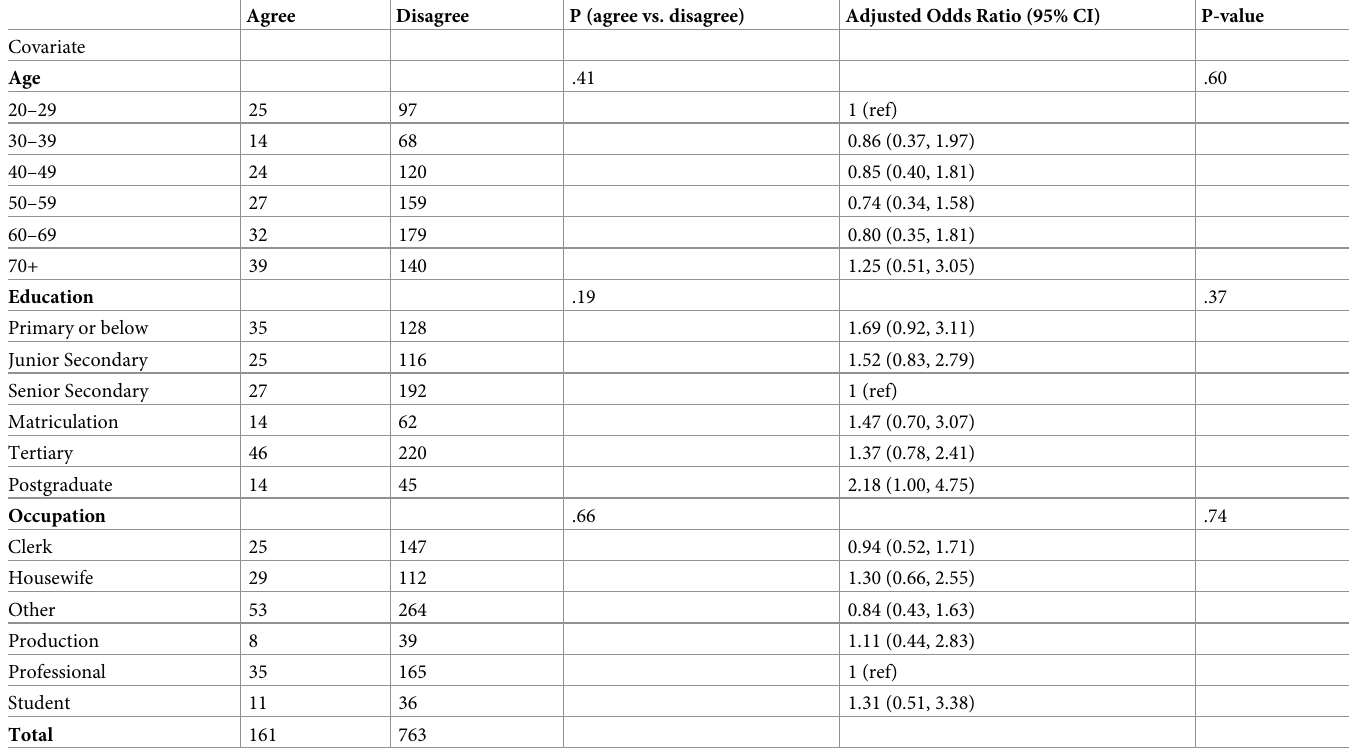
Table 3. Univariable and multiple logistic regression analysis of agree vs. disagree with government financial support for foreign aid for social